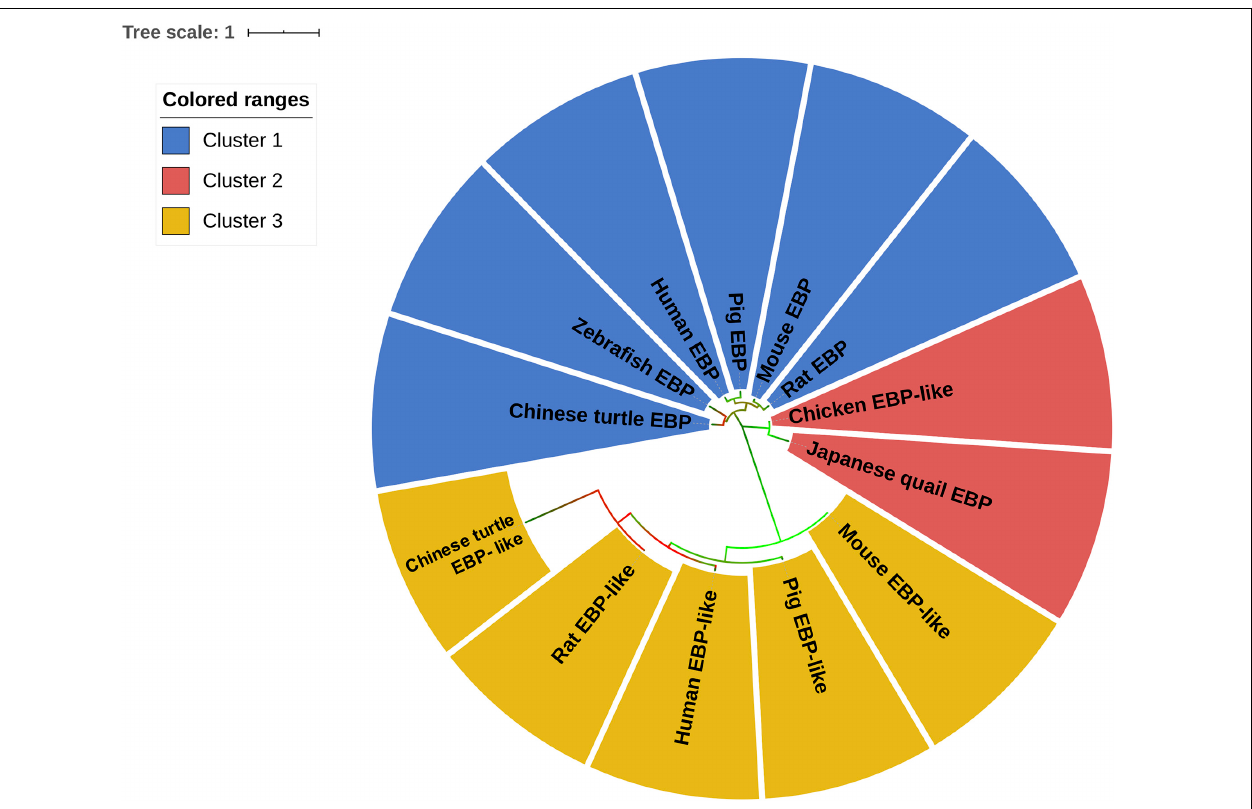
FIGURE 2 | Molecular phylogenetic analysis of EBP / EBP-like . The unrooted tree is drawn to scale, with branch lengths measured in the number of substitutions per site. Chicken EBP-like gene and EBP / EBP-like genes from other species were divided into three clusters according their protein sequences similarities. Different clusters are distinguished by